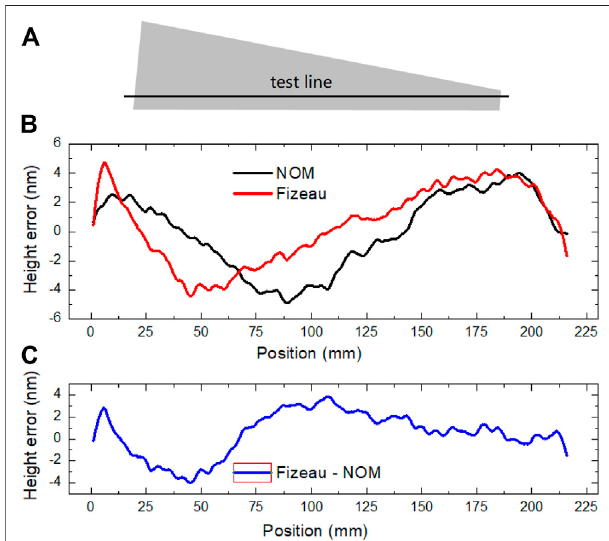
FIGURE 10 | (A) Schematic representation of the line position of HFM measuredbyNOM. (B) Comparisonofthelinepro fi lesmeasuredbyNOMand Fizeau interferometer after IBF. (C) Difference between the height pro fi les of two measurements.